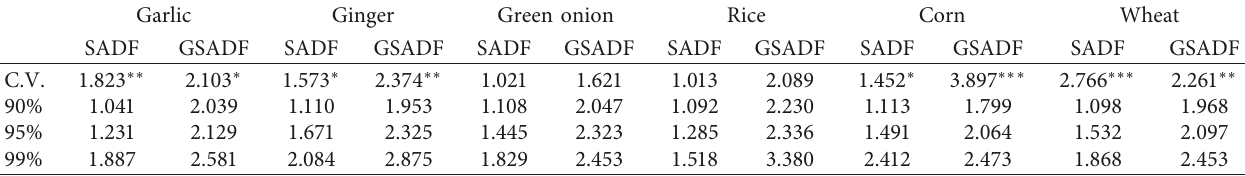
Table 1: Bubble detection results in Chinese agricultural commodity markets for 10 months.